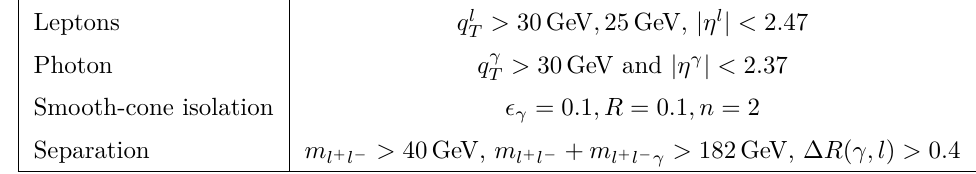
Table 6. Experimental cuts in Zγ production with Z → e + e − decay at a center of mass energy √ s = 13 TeV .